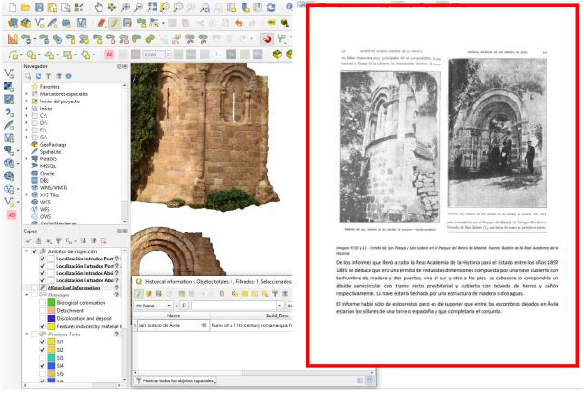
Figure 10. Appearance of the QGIS project at the moment of which the historical information is consulted.